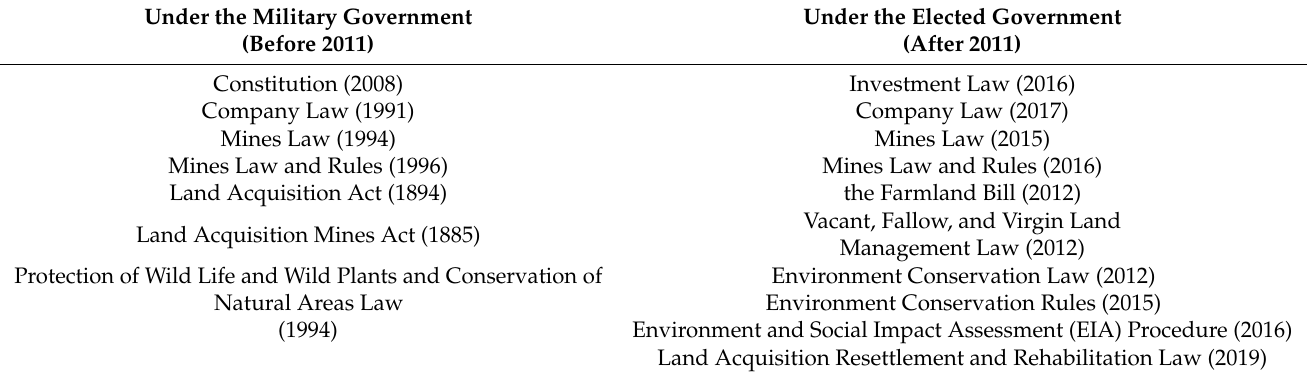
Table 1. Laws and regulations relating to the mining investment in